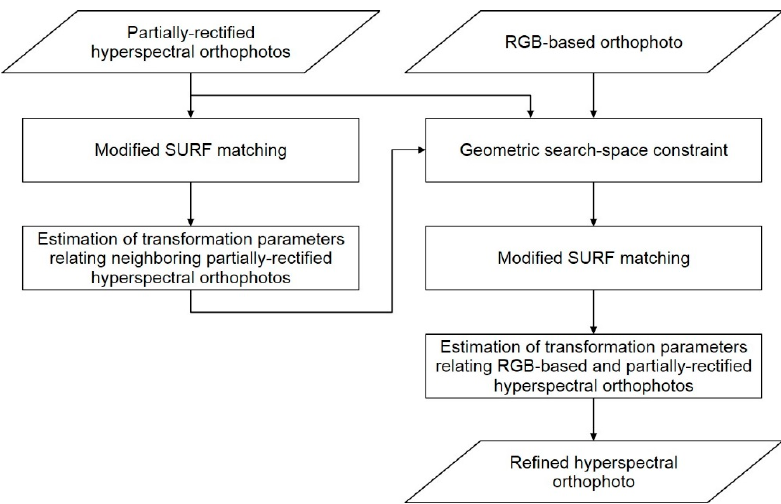
Figure 1. Flowchart of the proposed methodology for the automated registration of RGB-based and partially-rectified hyperspectral orthophotos.